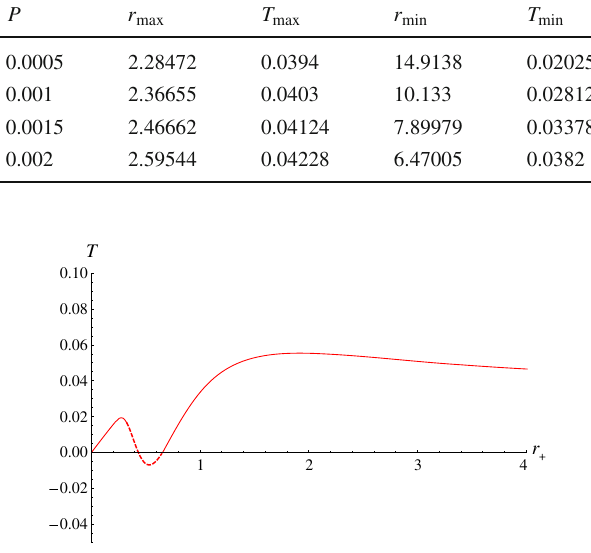
Fig. 5 TheisobariccurveforthecaseIIisplottedat α = 0 . 5, k = 0 . 55, √ P = 3 and q = 2.Thereisnotheblackholesolutioninthedashed 100 π